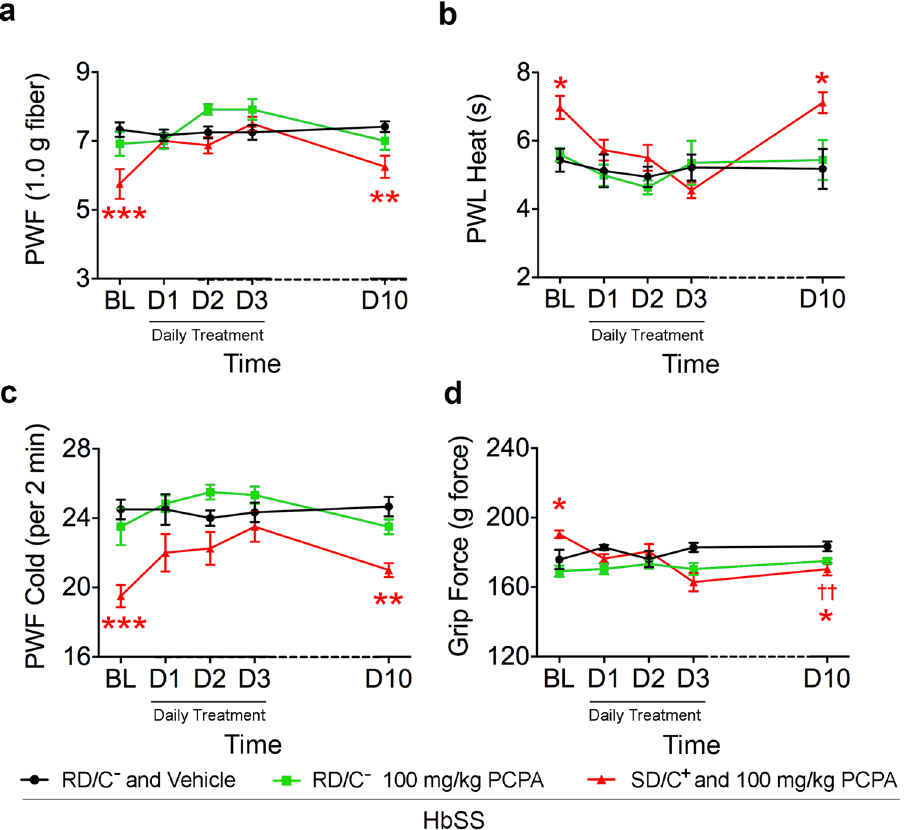
Figure 5. Effect of p-chlorophenylalanine (PCPA) on hyperalgesia in male sickle mice. Male sickle mice fed regular diet and housed singly without a companion (RD/C −) were treated with vehicle or 100 mg/Kg PCPA/ day and mice fed sickle diet and housed with a female companion were treated with 100 mg/Kg PCPA/day. Hyperalgesia measures for all mice are shown for, mechanical hyperalgesia as PWF in response to 1.0 g von Frey filaments; heat hyperalgesia as PWL in response to a heat stimulus; cold hyperalgesia as PWF per 2 min on a cold plate at 4 °C and deep tissue/musculoskeletal hyperalgesia as grip force exerted by forelimbs. Male HbSS-BERK mice between 8 and 10 months of age were used. Regular diet without companionship, RD/C−, nSS vehicle = 8, nSS 100 mg/kg PCPA = 13; sickle diet with companionship, SD/C+, nSS 100 mg/kg PCPA = 4; mixed linear models with Tukey’s post-hoc test, * p < 0.05, ** p < 0.01, *** p < 0.001 compared to RD/C− with vehicle; †† p < 0.01 compared to SD/C+ at baseline. D1, D2, D3, D10, day 1, 2, 3, and 10 respectively; PWF, paw withdrawal frequency; PWL, paw withdrawal